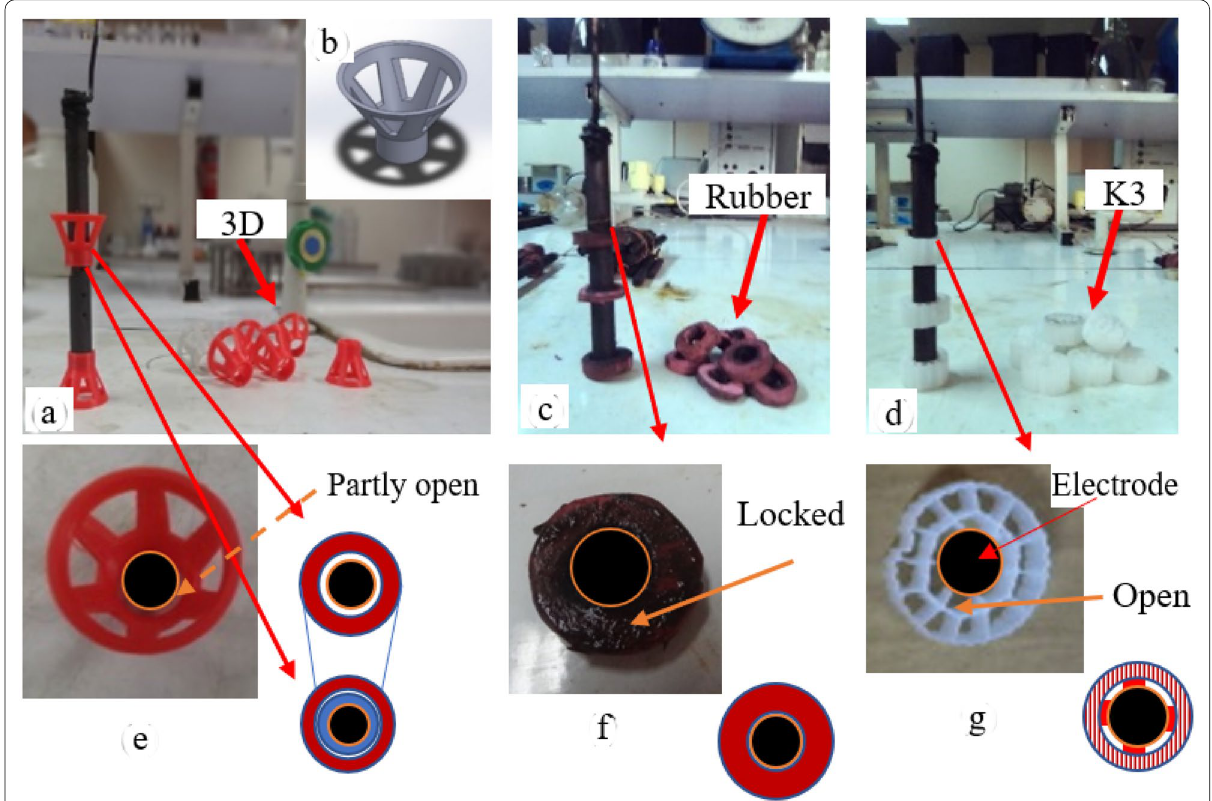
Fig. 5 Different microbial electrode jacket-dish (MEJ-dish) used during this study a 3D, b 3D design, c Rubber, d K3 MEJ-dish, and e – g junction between the electrode and MEJ-dish: partly opened (closed), open, and locked (closed). Locked (closed) indicates no space between the electrode and MEJ-dish, partly open shows the upper part is open, but the lower part is partially open or closed, and open means the connection part is exposed for microbial